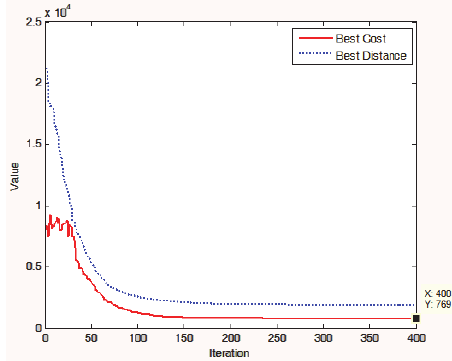
Fig. 11. Problem solution (two-objective